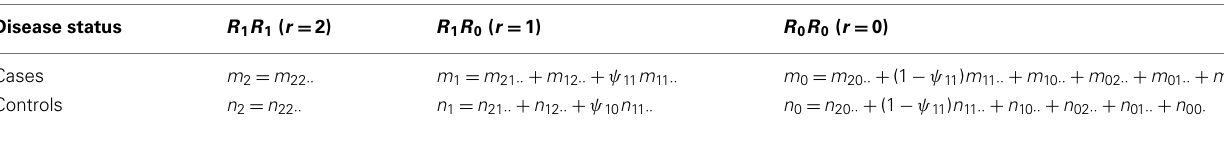
Table 2 | Frequencies of composite diplotypes for 2 SNPs at block 1 in both cases and controls assuming that AB is the risk